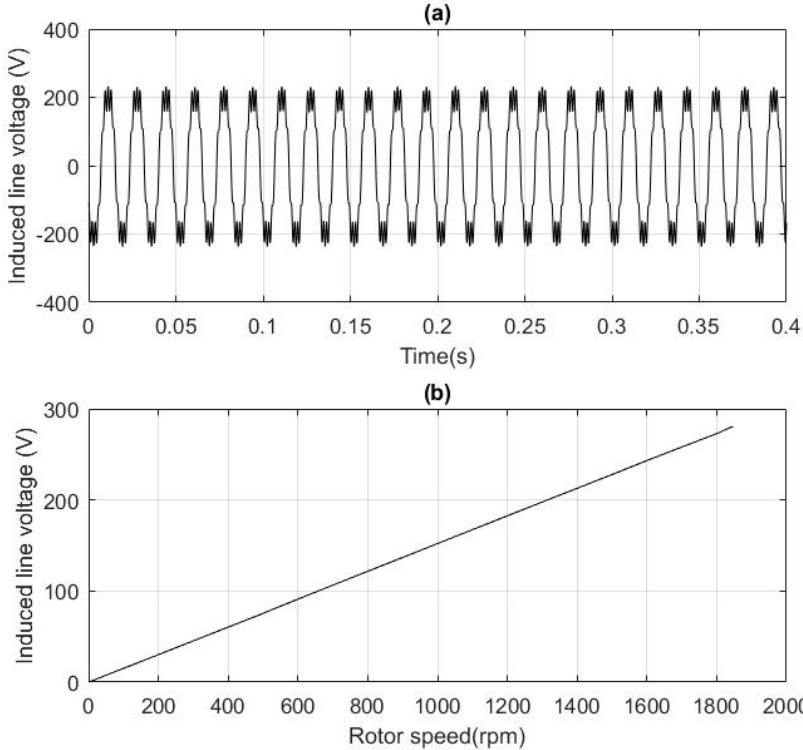
Figure 18. ( a ) Induced line voltage at 1060 rpm rotor speed ( b ) relation between rotor speed and induced line voltage.